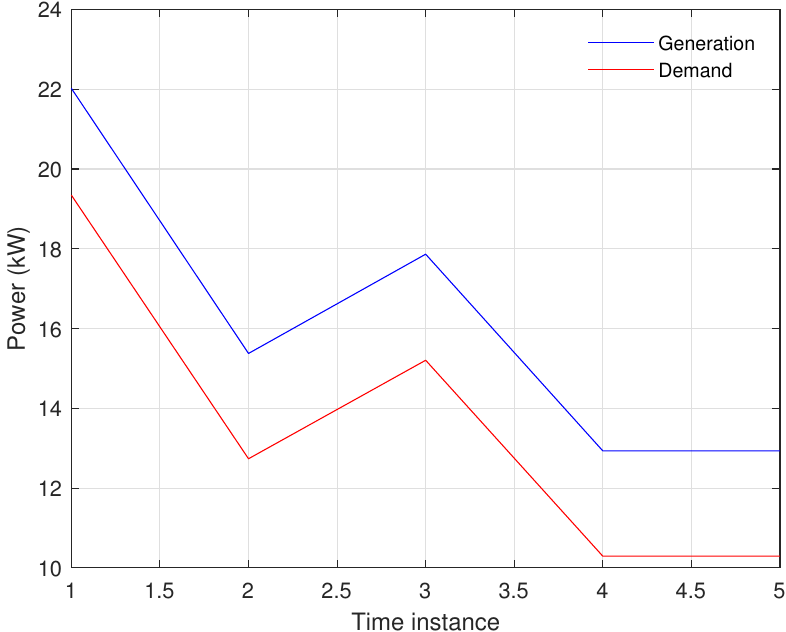
Figure 8. Demand and supply profile during shortfall after SLS for data